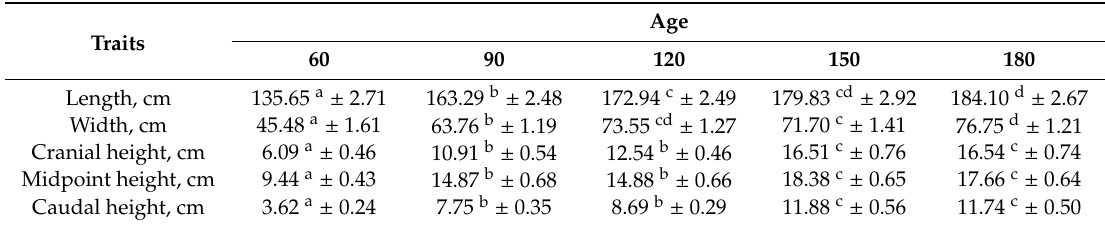
Table 3. E ff ect of age on breast dimensions of Da-Heng meat type birds.